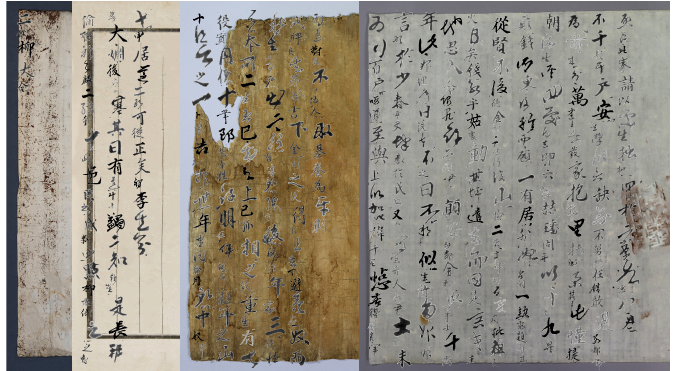
Figure 5. Example of a character data-set augmented into a background